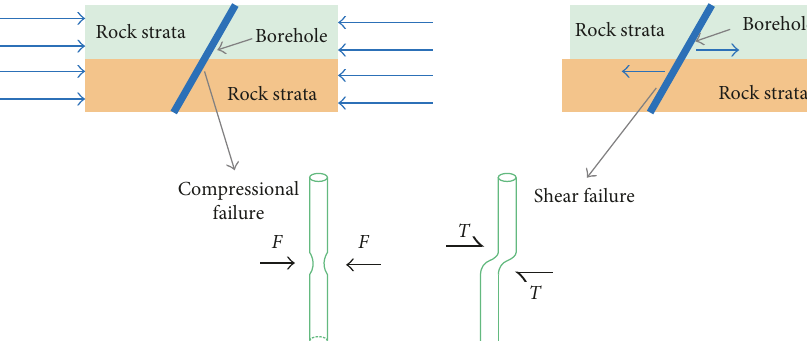
Figure 2: Schematic diagram of compressional and shear failure of a borehole induced by coal mining (modified from Liu et al. [24]).